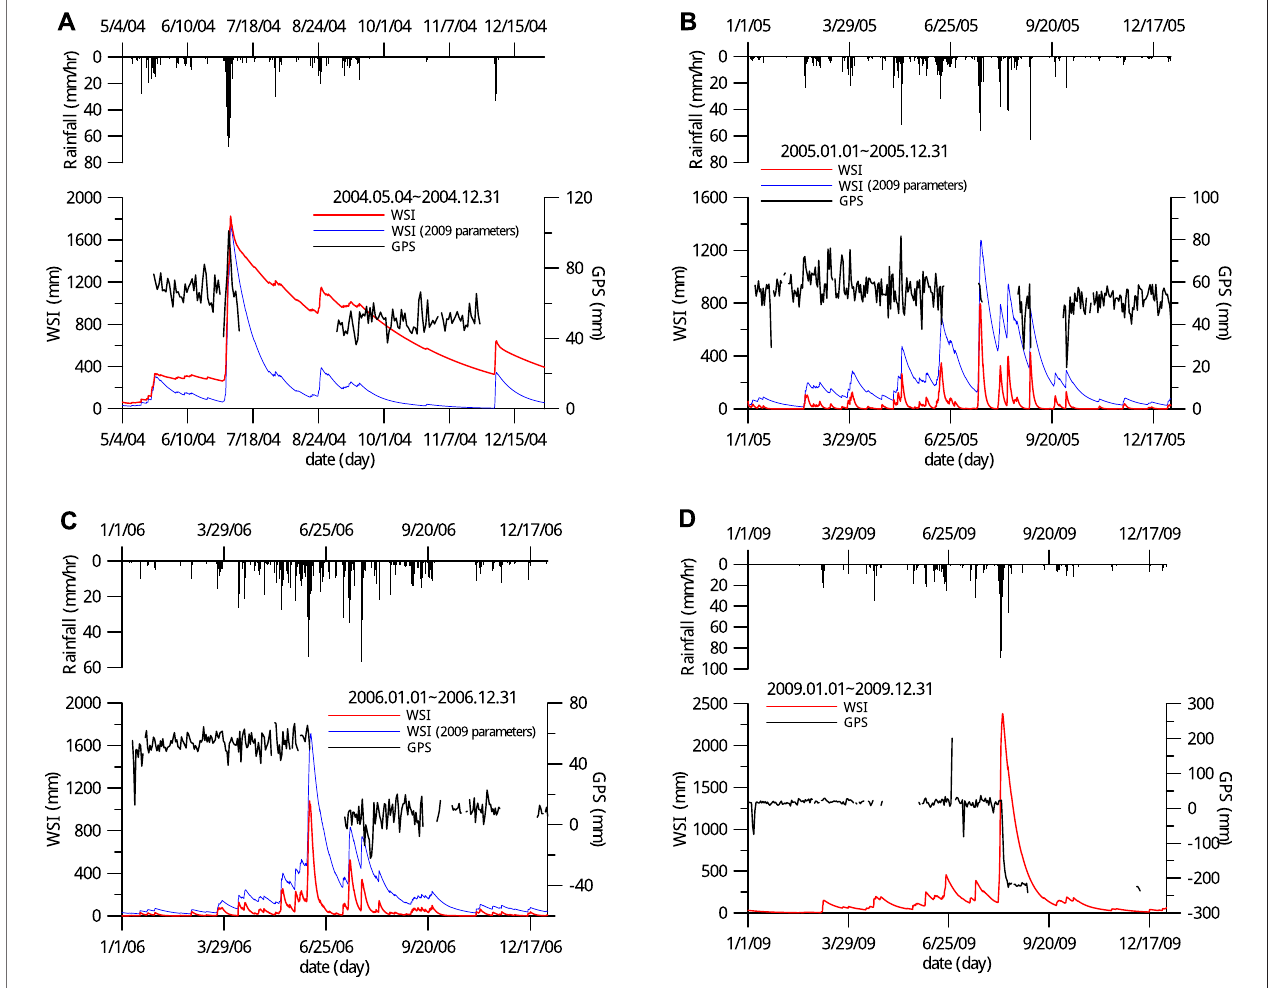
FIGURE 10 | RI, WSI and GPS displacement of the four landslide events. WSI-2009 curves are WSI predictions using 2009 tank model parameters and they are superimposed for amodel sensitivity check. The light blue shaded lines are landslide thresholds: between 350 ∼ 400 mm for WSI and approximately 40 mm/h for rainfall intensity. The associated landslide events from panels (A – D) are 6/29/2004 (Month/Day/Year) Mindulle typhoon, 7/18/2005 Haitang typhoon, 5/17/2006 heavy rainfall and 8/7/2009 Morakot typhoon.